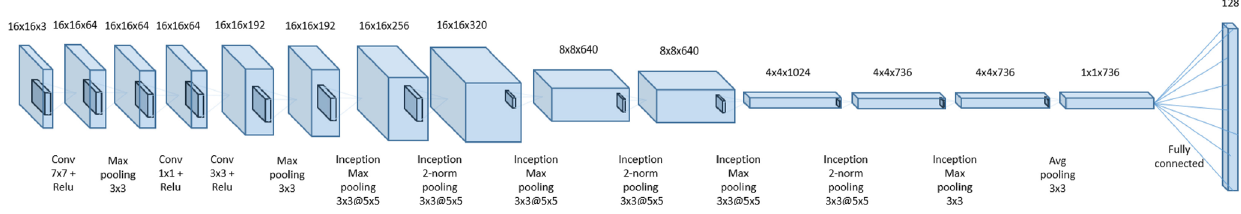
Fig. 5 Our network